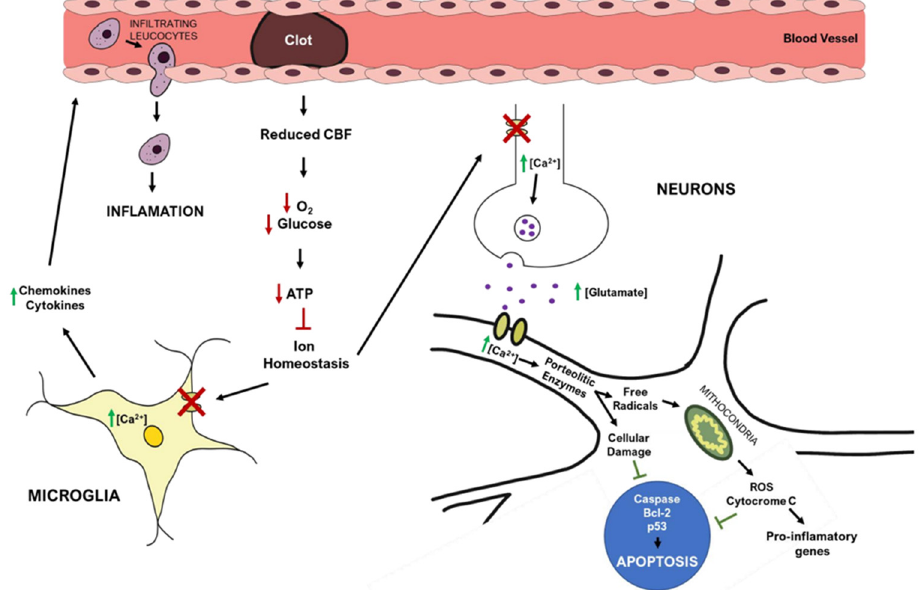
Figure 2. Simplified overview of stroke’s pathophysiology: molecular pathways occurring in the brain after ischemic stroke. Red arrows represent decreased events, while green arrows represent increased events.